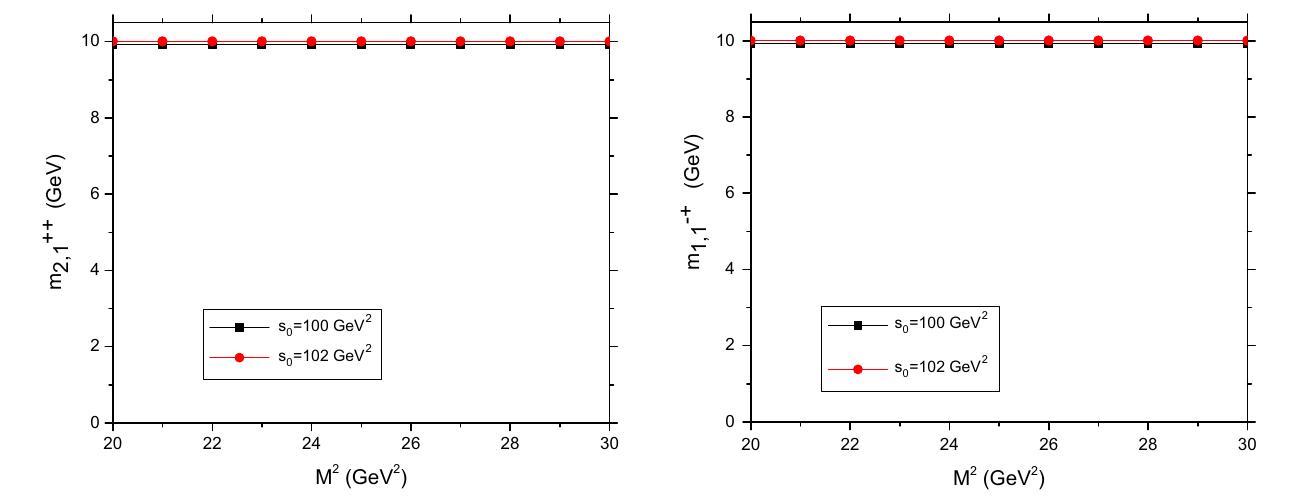
Fig. 10 Borelparameterdependenceof J PC = 1 −+ mesonmassfrom (cid:10) ( 1 ) μναβ for different s 0